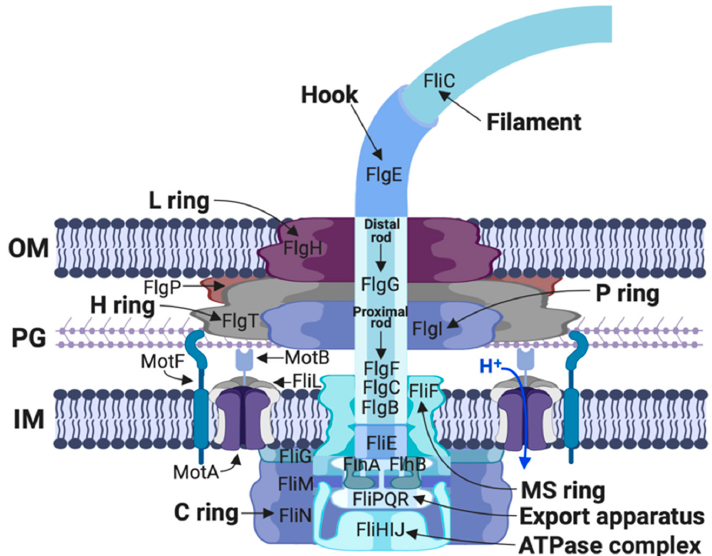
Figure 4. Schematic drawing of the R. sphaeroides flagellar motor. The model is based on the electron microscopic analysis of isolated flagella of R. sphaeroides , as well as inferences based on protein-protein interaction analysis and in situ visualization of the flagellar structure of Vibrio . The name of the di ff erent components and proteins that form this structure are indicated. This figure was created with BioRender.com (website: https://biorender.com/).